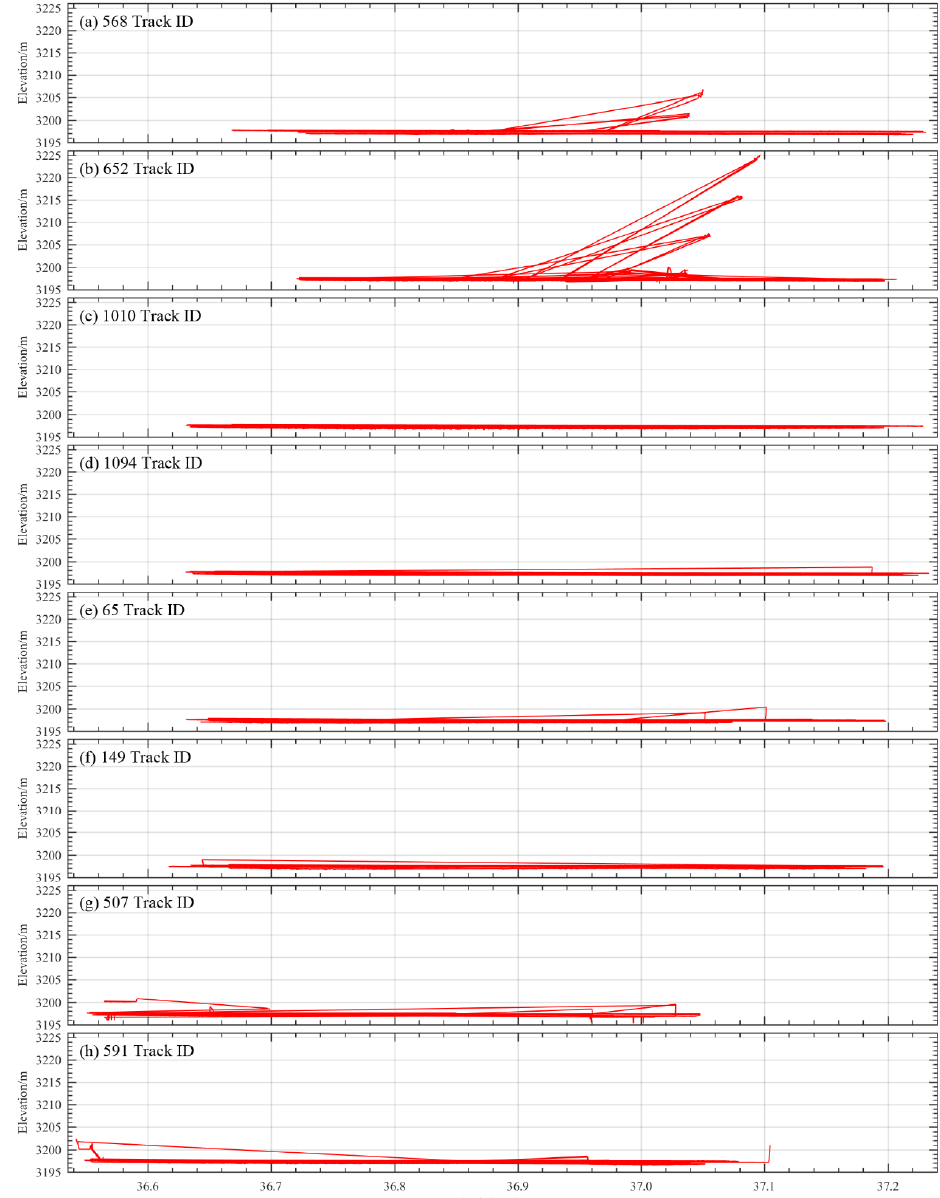
Figure 5. The elevation variation along the latitude in each track of ICESat-2.